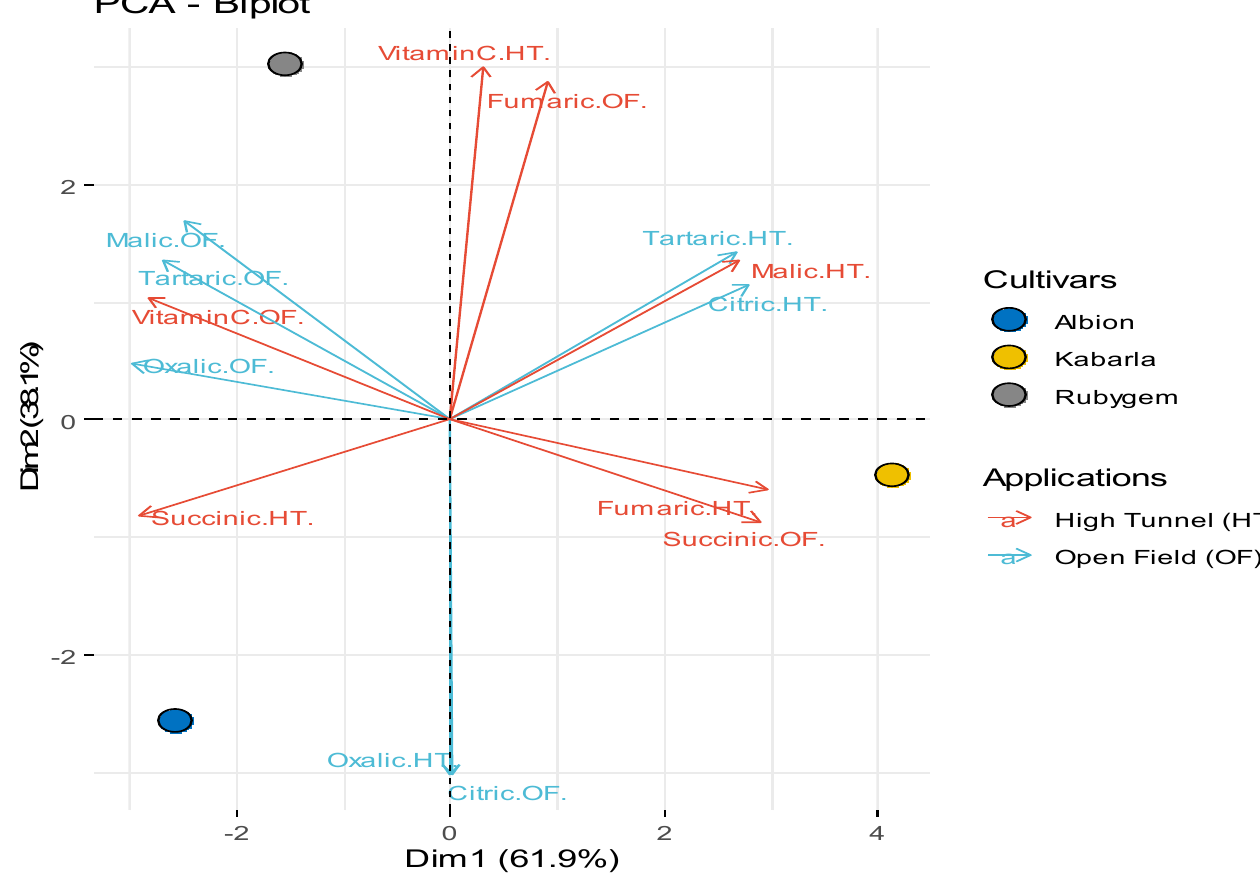
Figure 4. Principal component analysis (PCA) for organic acids of different varieties and different applications.